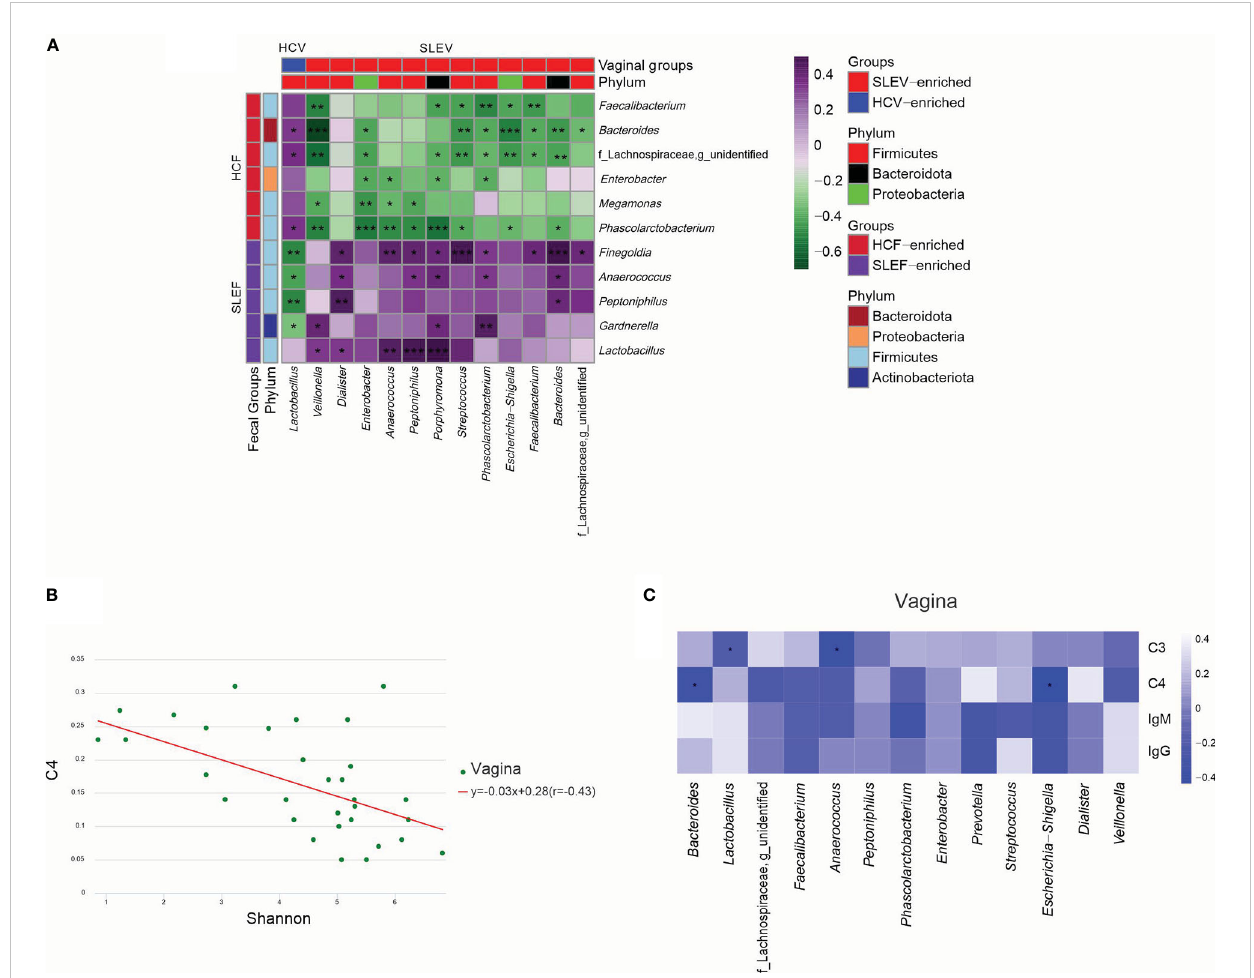
FIGURE 5 Associations of the microbiome. (A) Pearson correlation analysis was performed between the bacterial genera that differed in the feces of SLE patients and bacterial genera that differed in the vaginas of patients. (B) Pearson correlation analysis was performed between the Shannon index and serum C4 in the vaginas of SLE patients. (C) Pearson correlation analysis was performed between the bacterial genera that differed in the vaginas of patients and their immunological features. The correlation of two variables with values of | r |>0.3 and P< 0.05 are displayed. * P< 0.05; ** P< 0.01; *** P<